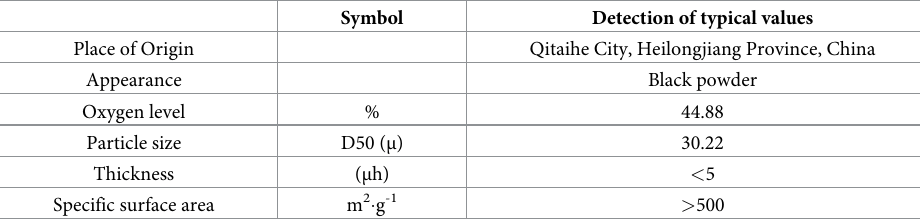
Table 2. The technical indicators of the GO used in this